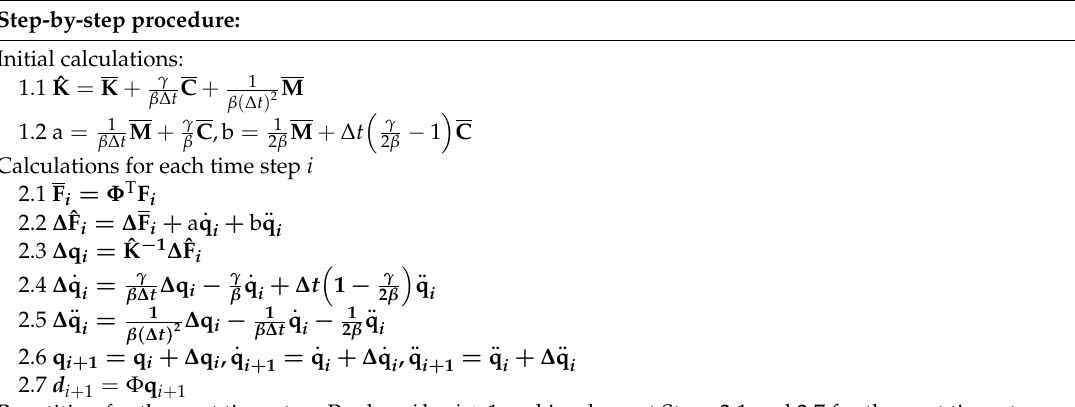
Table 2. Procedure of the Newmark method for multi-degrees of freedom